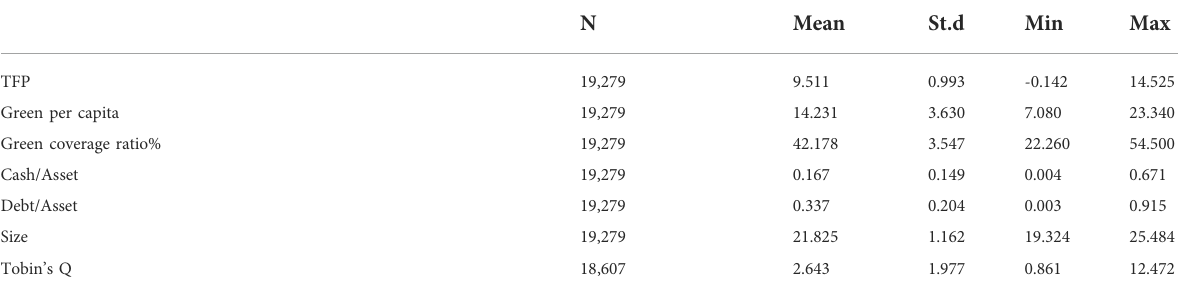
TABLE 1 Descriptive statistics. Panel A: Descriptive statistics results of all sample